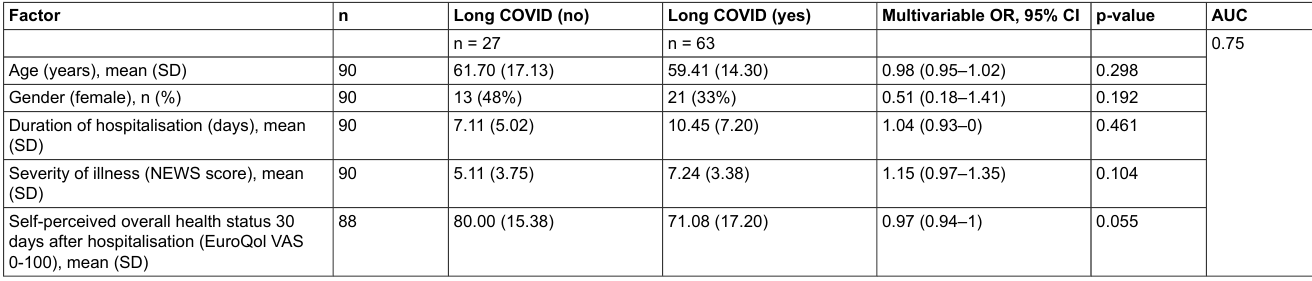
Table S1: Multivariable analyses of factors associated with long